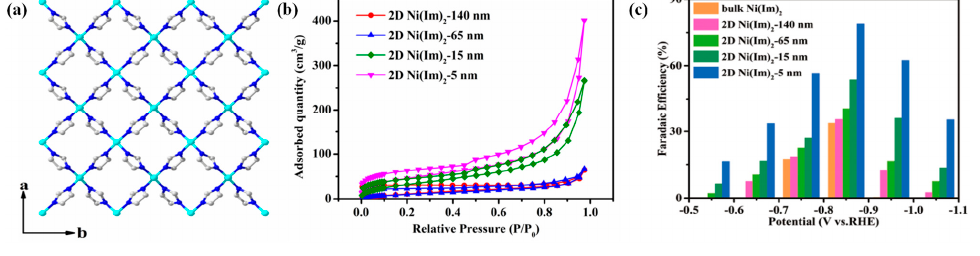
Figure 6. ( a ) Structure of NiPc − Ni(NH) 4 ; ( b ) N 2 adsorption/desorption isotherms of NiPc − Ni(NH) 4 ;